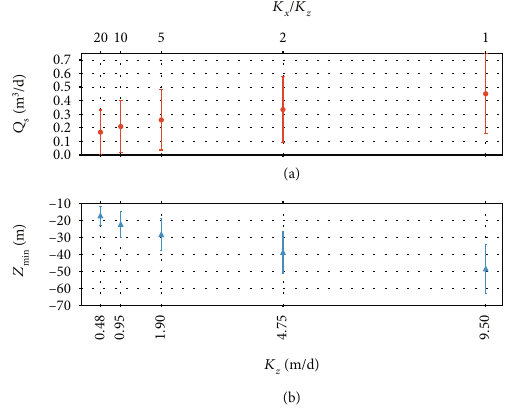
z Figure 9: Dependency of (a) seawater in fl ow Q s and (b) min (the elevation of the deepest point where 3 H > 0.02 TU) on vertical hydraulic conductivity K z for simulation A3 with di ff erent anisotropy ratios. The corresponding anisotropy ratios are displayed along the top horizontal axis of the graph. Q s was calculated by summing the in fl ow across the speci fi ed head cells along the sea fl oor. The vertical error bars represent one standard deviation of the temporal variability of Q s and z min , which is caused by the transient recharge (Figure